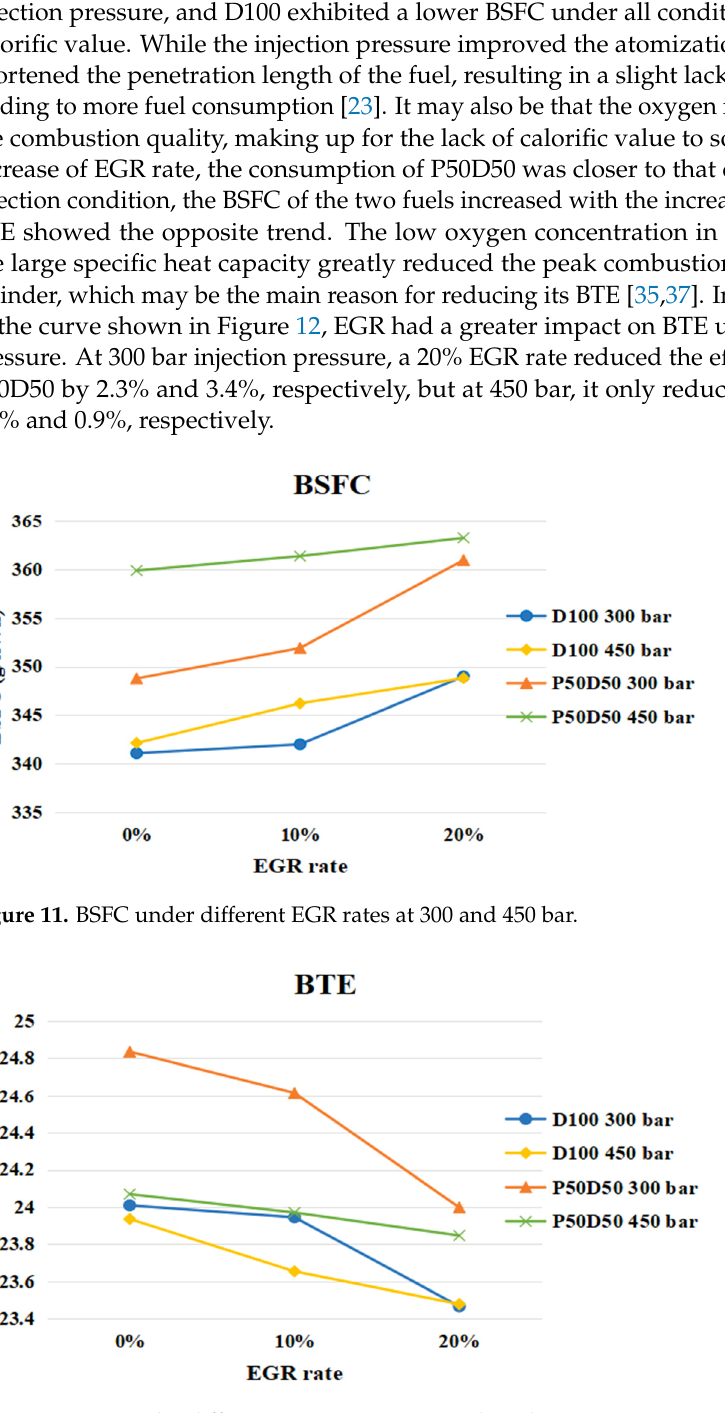
Figure 12. BTE under different EGR rates at 300 and 450 bar.